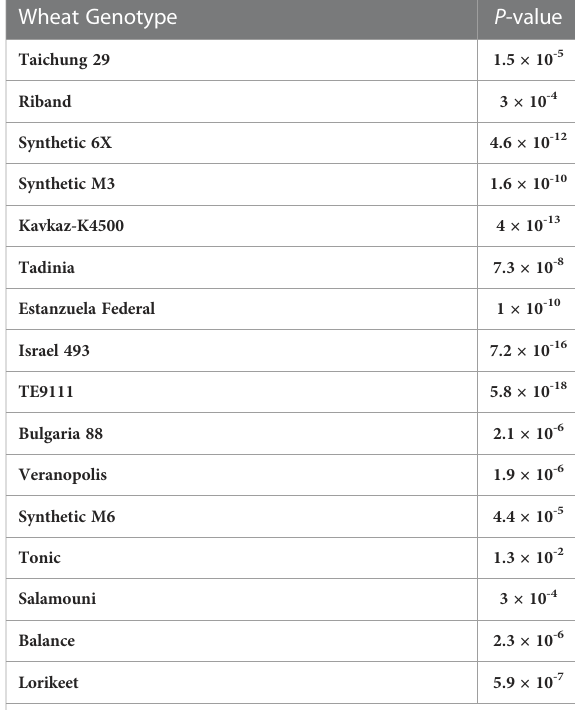
and the equivalent values derived from the Z. tritici isolate ’ s interactions with the KWS Cashel susceptible control. Wheat